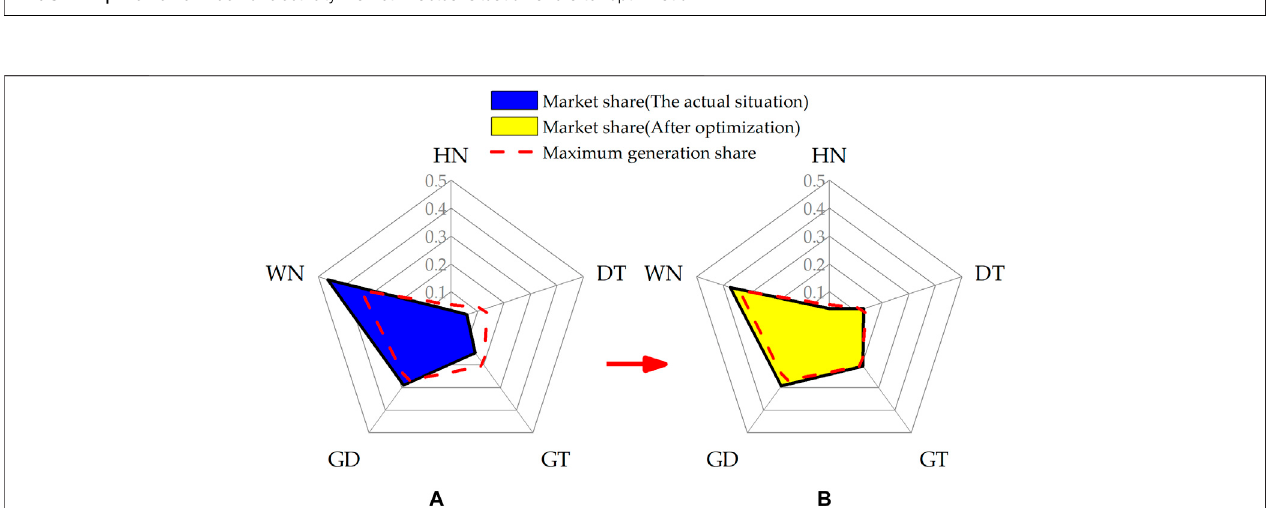
FIGURE 5 | The market shares and maximum generation shares of GCs: (A) in actual situation; (B) after optimization.